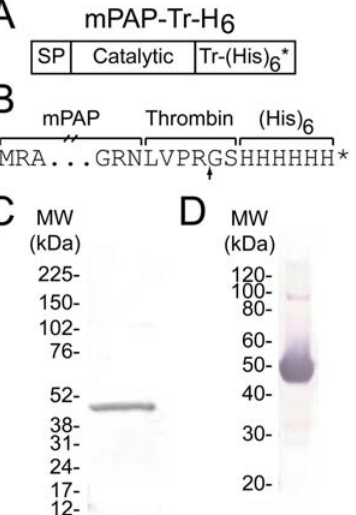
Figure 1. Purification of recombinant mPAP. (A) A thrombin cleavage site (Tr) followed by hexahistidine tag (H 6 ) and stop codon (*) were added to the C-terminus of the secretory isoform of mPAP. SP=signal peptide of mPAP. Map is not drawn to scale. (B) Amino acid sequence at the junction between the catalytic domain and Tr-H 6 tag. Arrow marks thrombin cleavage site. Asterisk marks stop codon. (C) GelCode blue-stained SDS-PAGE gel and (D) western blot of purified recombinant mPAP protein (1 m g and 5 m g, respectively). The western blot was probed with an anti-hexahistidine antibody.